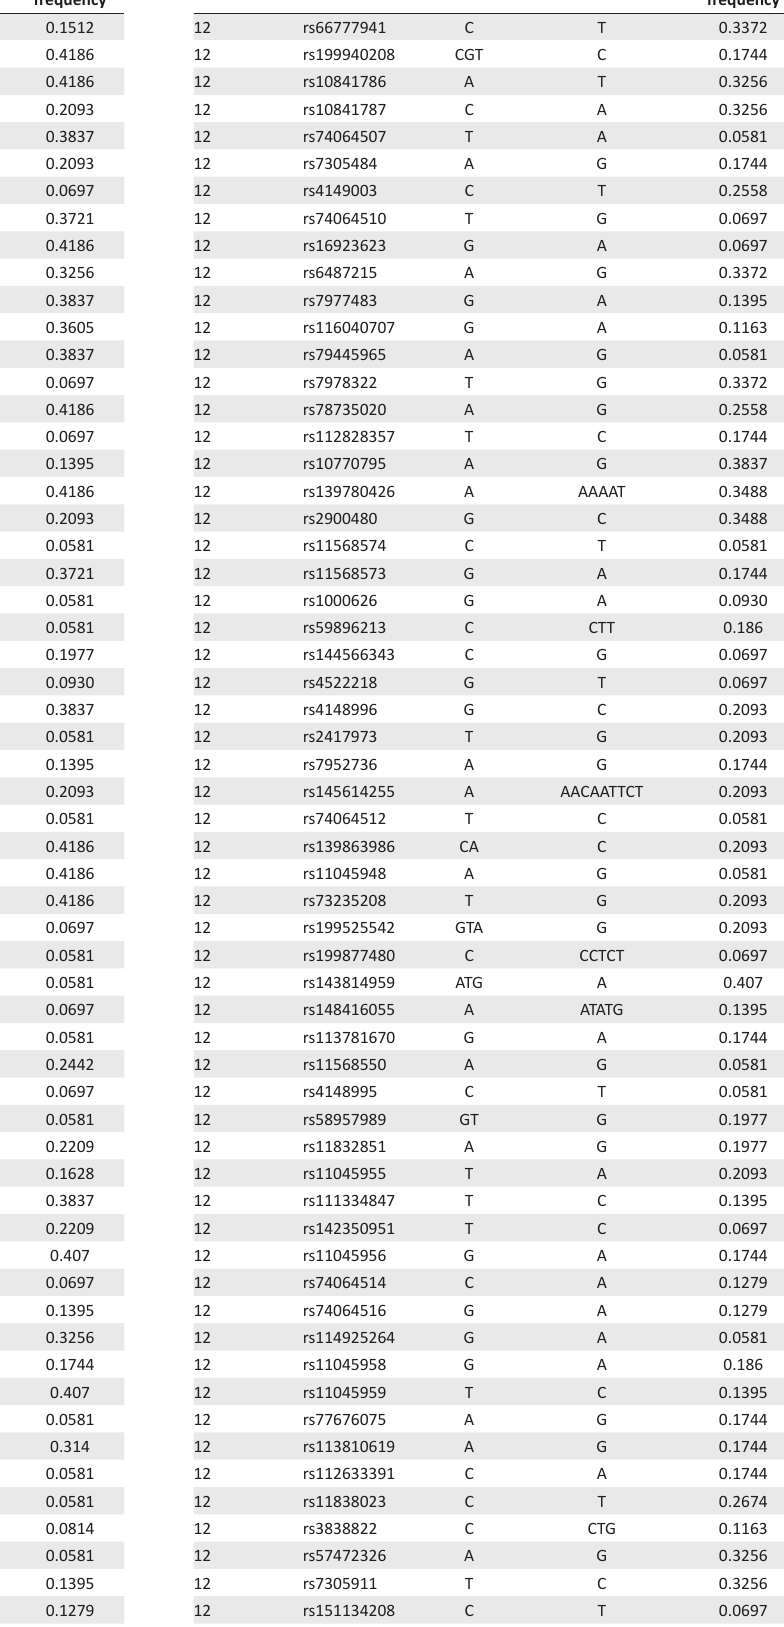
Table 1-A1 (Continues...): Minor allele frequencies for 1846 polymorphisms in 43 black South Africans. Chromosome Polymorphism Minor allele